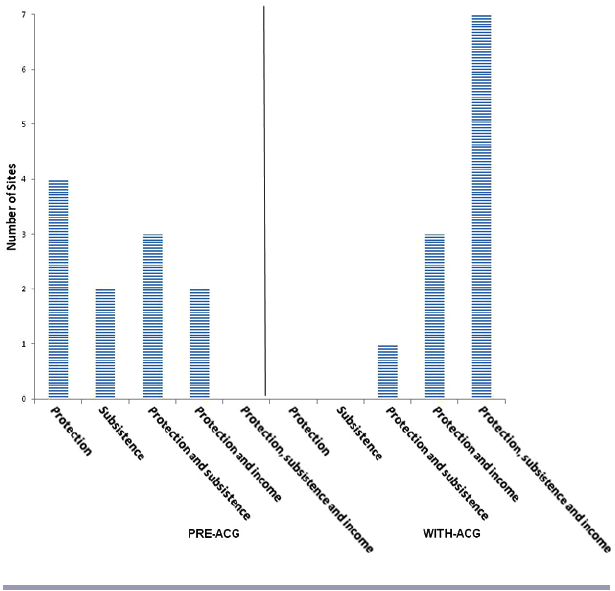
Fig. 2 . Changes in CFUG orientation: bomparing pre-